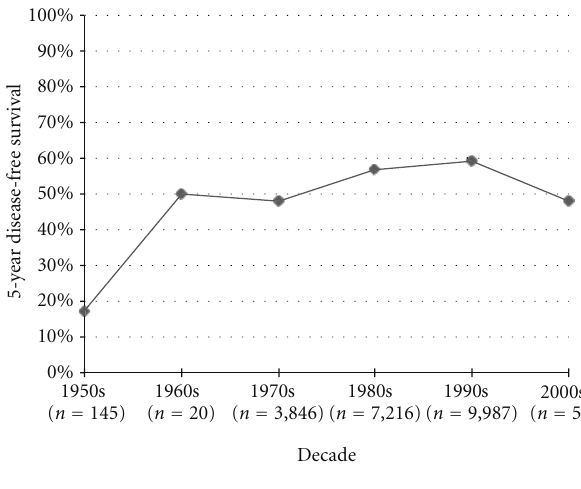
Figure 4: Osteosarcoma 5-year disease-free durvival.